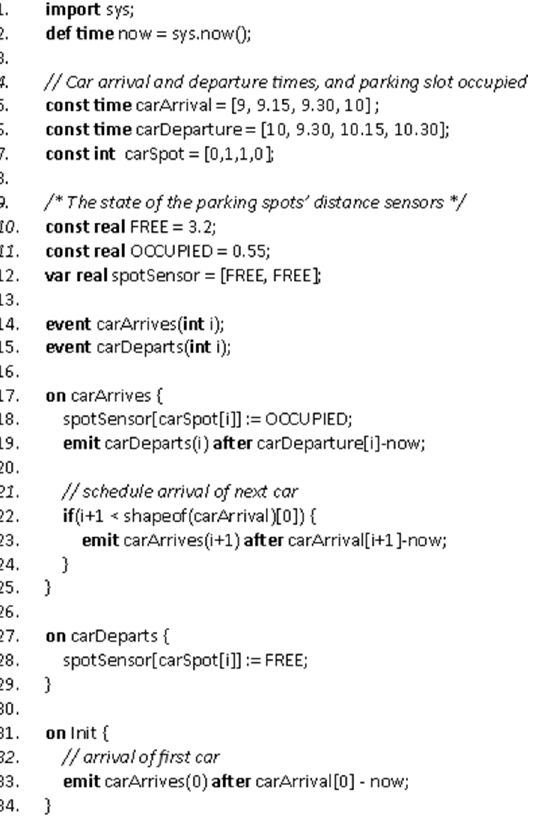
Figure 13. A simple VectorL program.